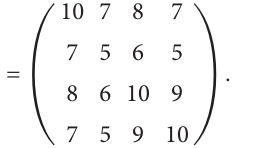
Table[A[l] = RandomComplex [ {− 10 − 10